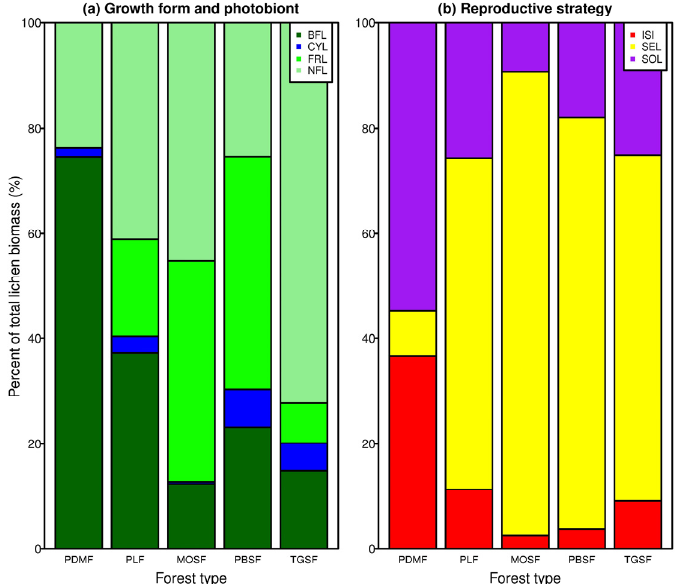
Figure 3. The biomass composition of functional groups divided by ( a ) growth form and photobiont and ( b ) reproductive strategy of epiphytic lichens in five forest types in the Ailao Mountains, Southwest China. PDMF: primary dwarf mossy forest; PLF: primary Lithocarpus forest; MOSF: middle ‐ aged oak secondary forest; PBSF: Populus bonatii secondary forest; TGSF: Ternstroemia gymnanthera secondary forest. BFL: broadly ‐ lobed foliose lichens; CYL: cyanolichens; FRL: fruticose lichens; NFL: narrowly ‐ lobed foliose lichens; ISL: isidiate lichens; SEL: sexual lichens; SOL: sorediate lichens. Table 2. The biomass (g ∙ tree − 1 ) of epiphytic lichen species in five forest types in the Ailao Mountains, southwest China. PDMF: primary dwarf mossy forest; PLF: primary Lithocarpus forest; MOSF: middle ‐ aged oak secondary forest; PBSF: Populus bonatii secondary forest; TGSF: Ternstroemia gymnanthera secondary forest. BFL: broadly ‐ lobed foliose lichens; CYL: cyanolichens; FRL: fruticose lichens; NFL: narrowly ‐ lobed foliose lichens; ISL: isidiate lichens; SEL: sexual lichens; SOL: sorediate lichens.